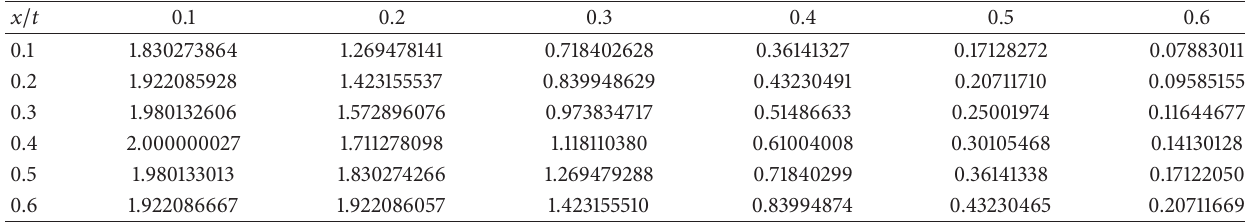
Table 2: The approximate solution of Example 10 for initial condition at 0.1 ≤ 𝑥 , 𝑡 ≤ 0.6 .